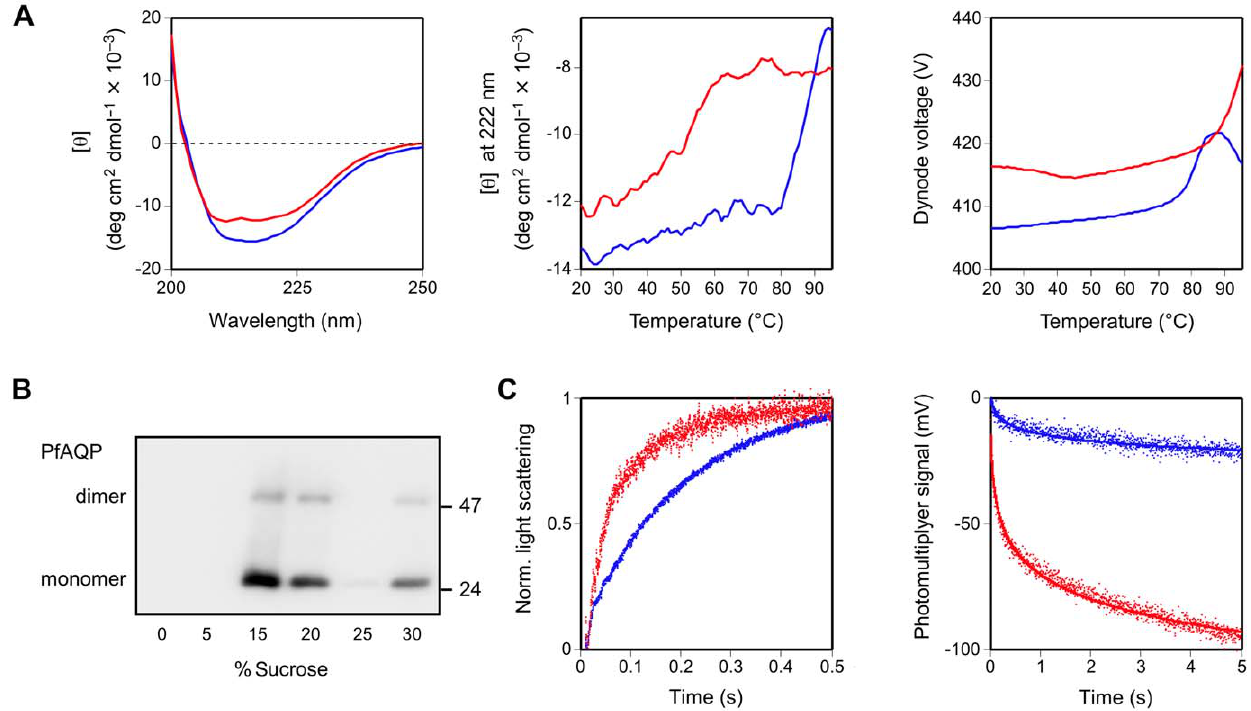
Figure 2. Structural and functional analysis of cell-free produced PfAQP without a GFP fusion. A . PfAQP in the presence of Brij35 (blue curve) and Brij78 (red curve) was analyzed by circular dichroism. The left panel shows the mean residue molar ellipticity [ h ] in the range of 200– 250 nm. Thermal unfolding was monitored at 222 nm from 20 u C to 95 u C (middle panel). A plot of the photomultiplyer dynode voltage versus temperature (right panel) indicates an increase in turbidity at 80 u C in the sample with Brij35 solubilized PfAQP suggesting protein agglomeration. B . Reconstitution of PfAQP, produced in the prescence of Brij78, into proteoliposomes was controlled by sucrose density gradient centrifugation and Western blot using an anti-His 5 antiserum. The fractions with 15% and 20% sucrose contained reconstituted liposomal PfAQP; the 30% sucrose fraction displays precipitated, non-integrated PfAQP protein. PfAQP monomers ( < 25 kDa) and dimers are visible. C . For functional analysis, PfAQP- proteoliposomes (red traces) and empty control liposomes (blue traces) were subjected to an outward osmotic gradient of 300 mosm kg 2 1 (left panel) and an inward isotonic glycerol gradient of 300 mM (right panel). Changes in the light scattering intensity reflect liposome shrinkage due to water efflux (increase in light scattering) and liposome swelling due to glycerol plus secondary water influx (decrease in light scattering). Note the difference of the scale of the abscissae as a consequence of lower glycerol permeability by at least one order of magnitude. The slow glycerol flux across the plain lipid liposome membrane did not reach a plateau, hence, the photomultiplyer signal was plotted without normalization. For each experiment nine traces were averaged and fitted to single exponential functions.